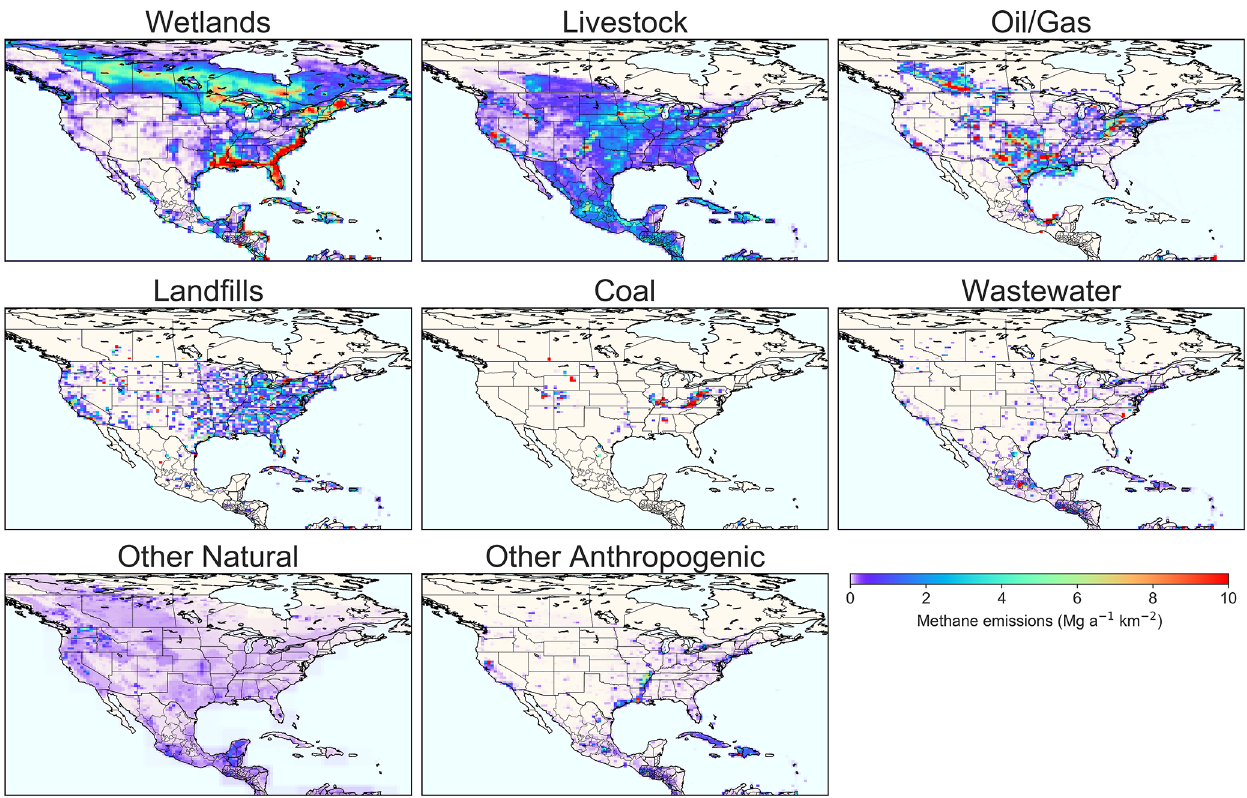
Figure 2. Mean prior estimates of methane emissions for 2010–2015. National totals, subsector breakdowns, and references are in Table 1.